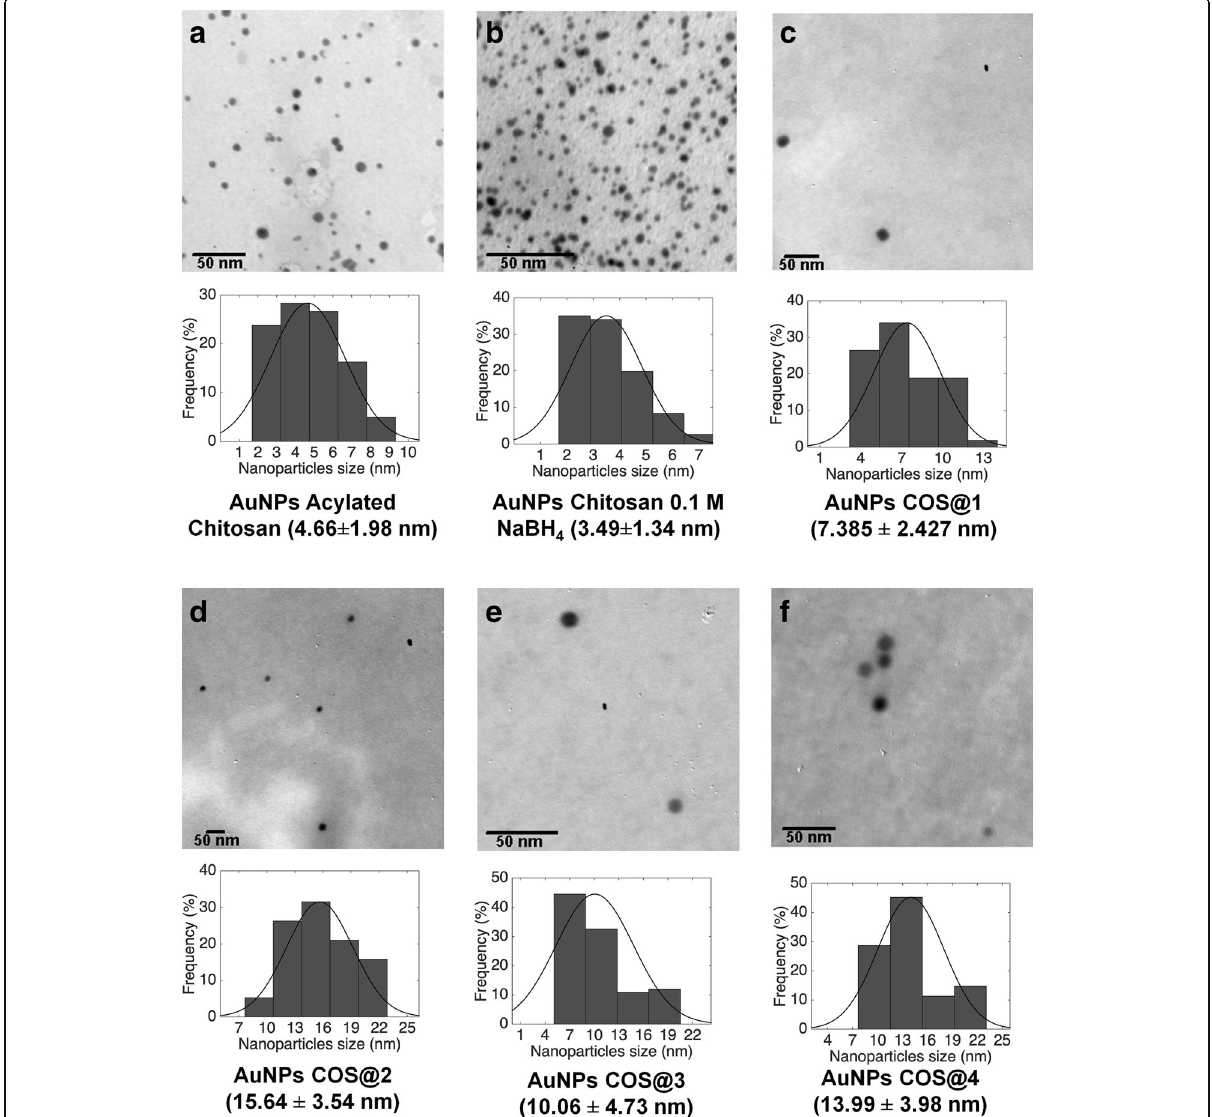
Fig. 6 TEM micrographs from a 4.7 nm acylated chitosan AuNPs, b 3.5 nm chitosan AuNPs (0.1 M NaBH 4 ), c 7.4 nm oligosaccharide chitosan AuNPs (COS@1), d 15.6 nm oligosaccharide chitosan AuNPs (COS@2), e 10 nm oligosaccharide chitosan AuNPs (COS@3), and f 14